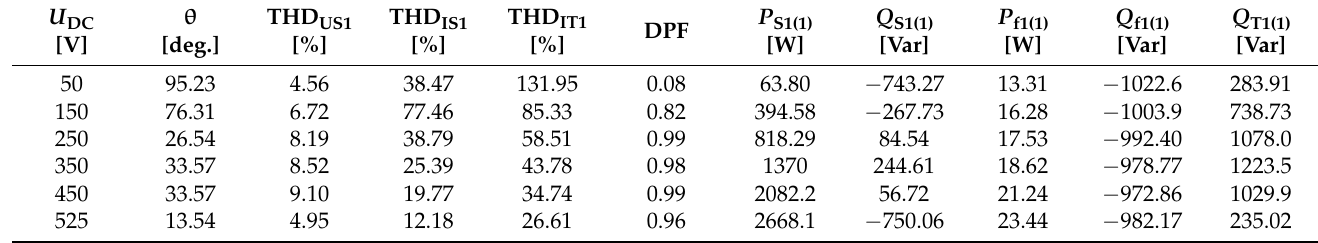
Figure 45. Laboratory equivalent circuit with filter and line reactor. Table 8. Power system parameters measured in the laboratory for different rectifier firing angles.